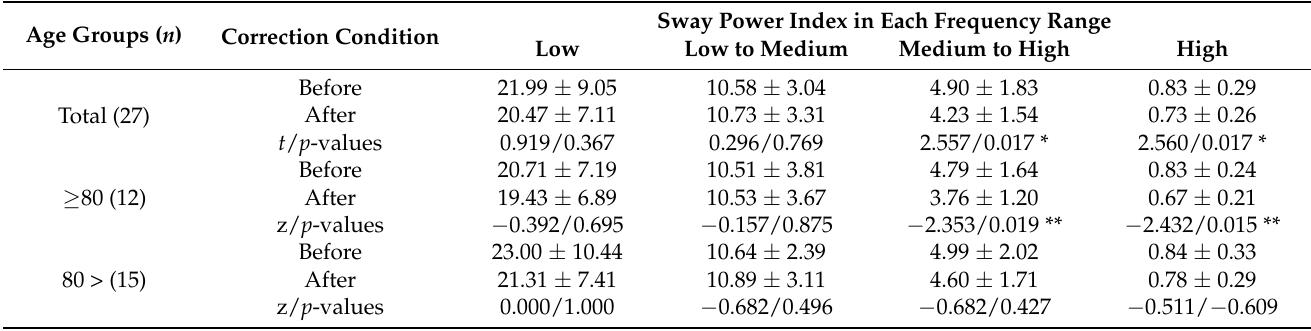
Table 3. Changes in sway power index in each frequency range before and after wearing corrective glasses.